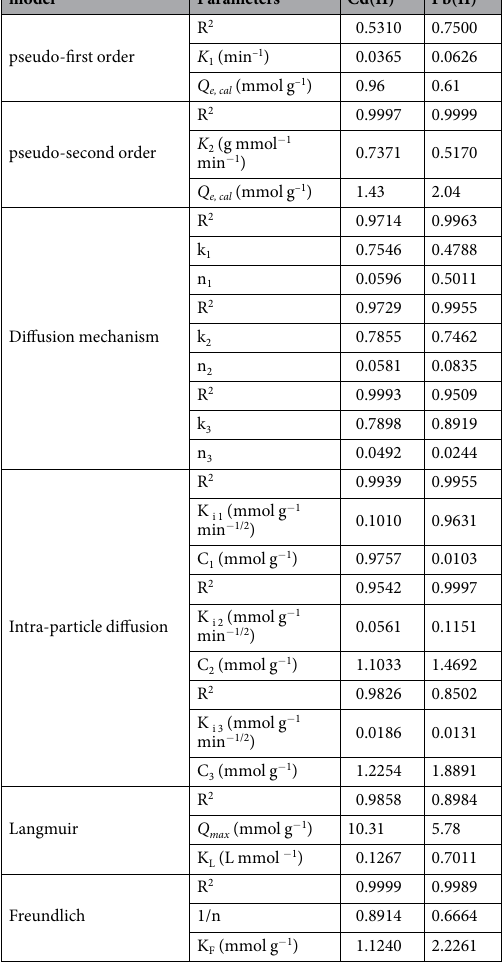
Table 3. Parameters of adsorption kinetics, diffusion kinetic and adsorption isotherms for the adsorption of Cd(II) and Pb(II) on SR–PAA